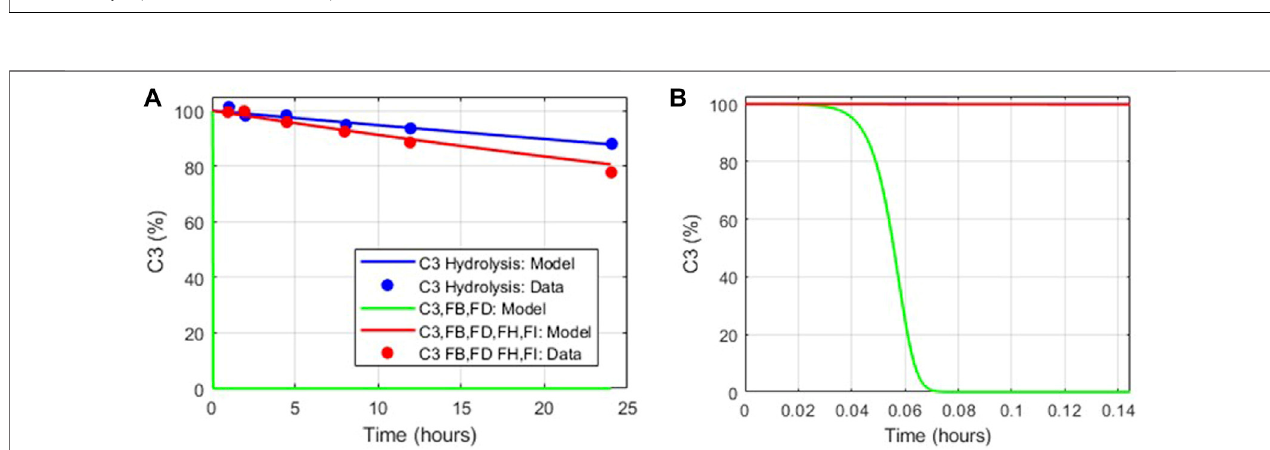
FIGURE 4 | Comparison of the tickover complement model dynamics with in vitro data (Pangburn et al., 1981). (A) Model simulations match in vitro data for C3 hydrolysis alone (blue), with FB, FD added (green) and with FH, FI, FB, and FD added (red). (B) Zoomed in view of model simulations for decay in C3 hemolytic activity in the presence of FB, FD